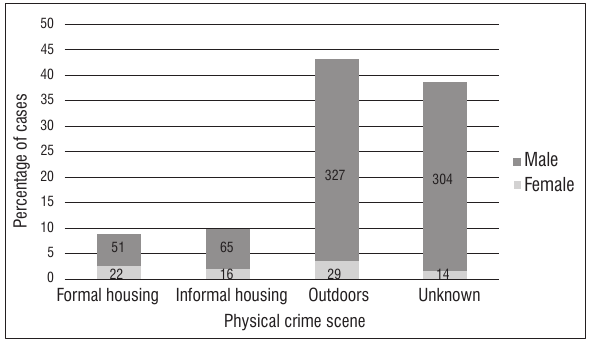
Figure 6: Percentage distribution of total number of victims and sex distribution in physical crime scene